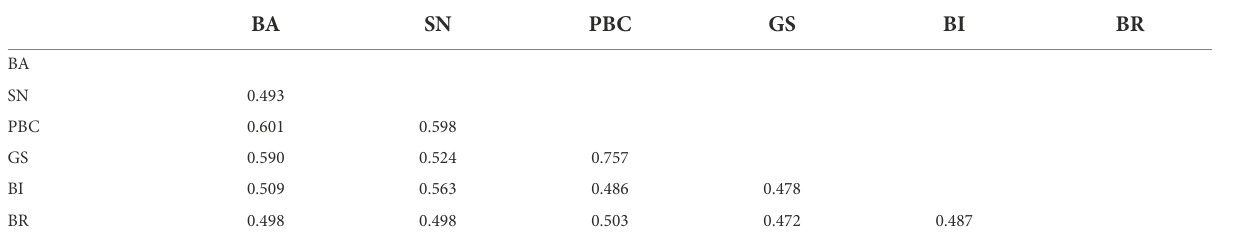
TABLE 4 Discriminant validity